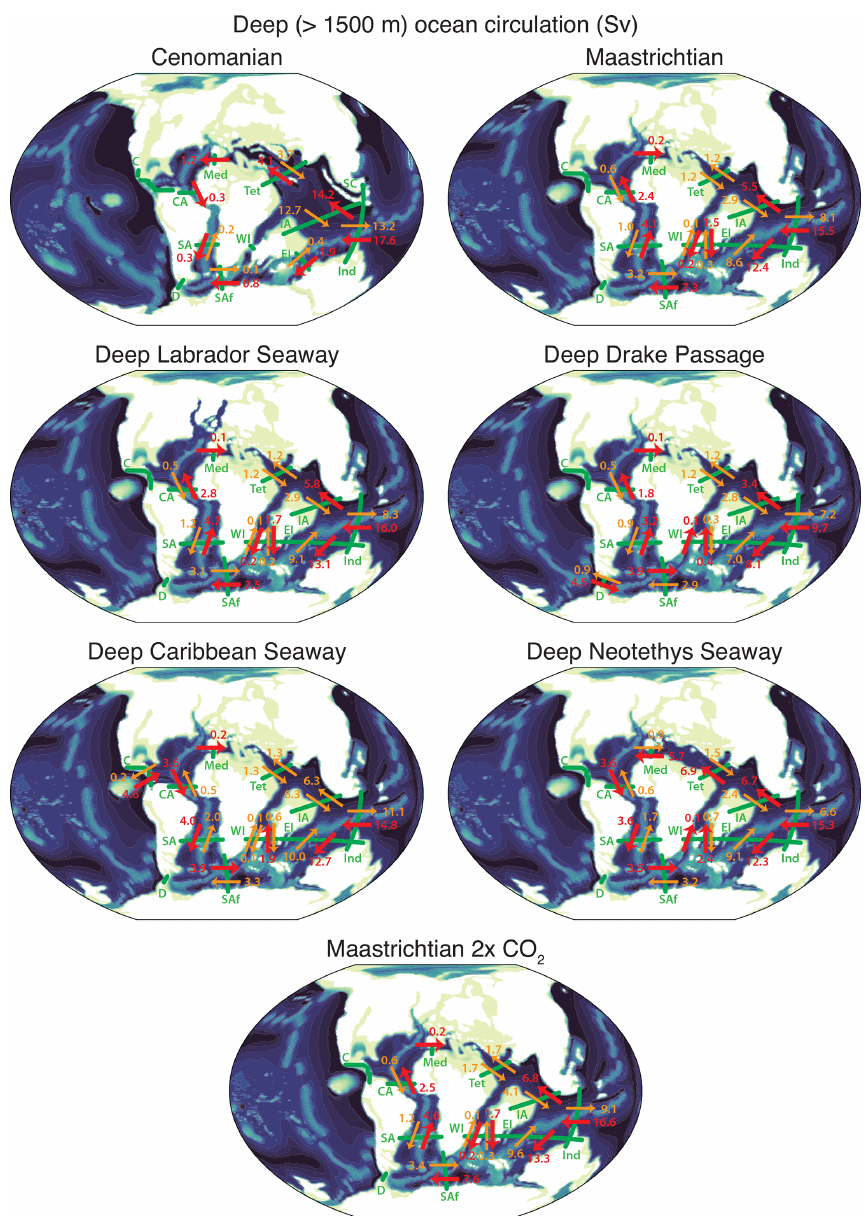
Figure 6. Deep (>1500m) water flow across major oceanic sections defined in Table S1 and represented in green for each simulation. As in Fig. 5, because flows vary across the range of depth depicted, summed flow in both directions across each section is shown with the larger flux in red and the smaller in orange. Thus, the direction of the red arrow gives the direction of the net intermediate flow across a section and the magnitude of the net flow is given by the difference between the fluxes represented by the red and orange arrows. Abbreviated sections: C (Caribbean), CA (Central Atlantic), D (Drake), EI (East Indian), IA (Indo-Asian), Ind (Indonesian), Med (Mediterranean), SA (South Atlantic), SAf (South African), SC (South China), Tet (Tethys), and WI (West